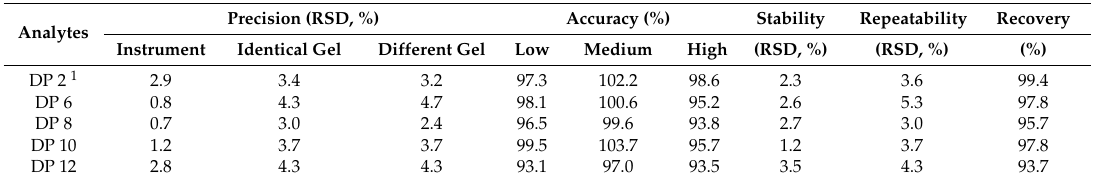
Table 2. Precision, accuracy, stability, repeatability, and recovery of neo-agarooligosaccharides. Precision (RSD, %) Accuracy (%) Stability Analytes Instrument Identical Gel Different